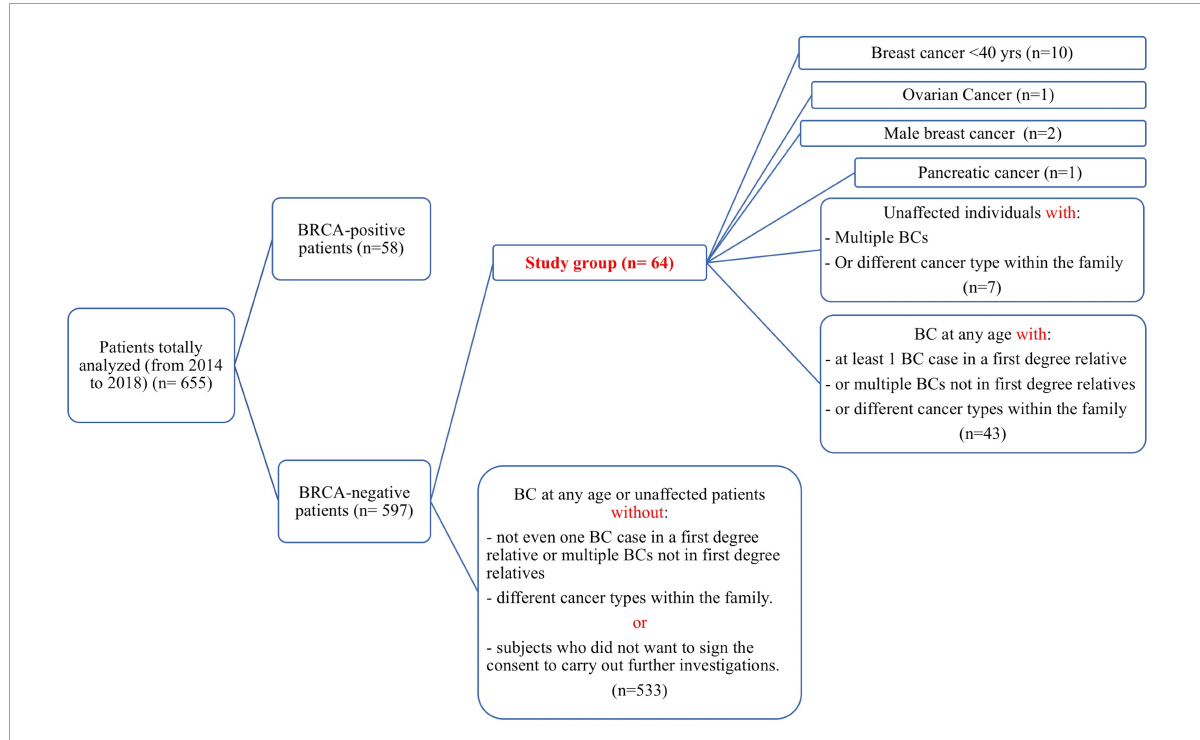
FIGURE1 Strobe diagram representing the study design and the inclusion criteria over an observation time of 5 years. For each category, the corresponding number of subjects is reported in parentheses.